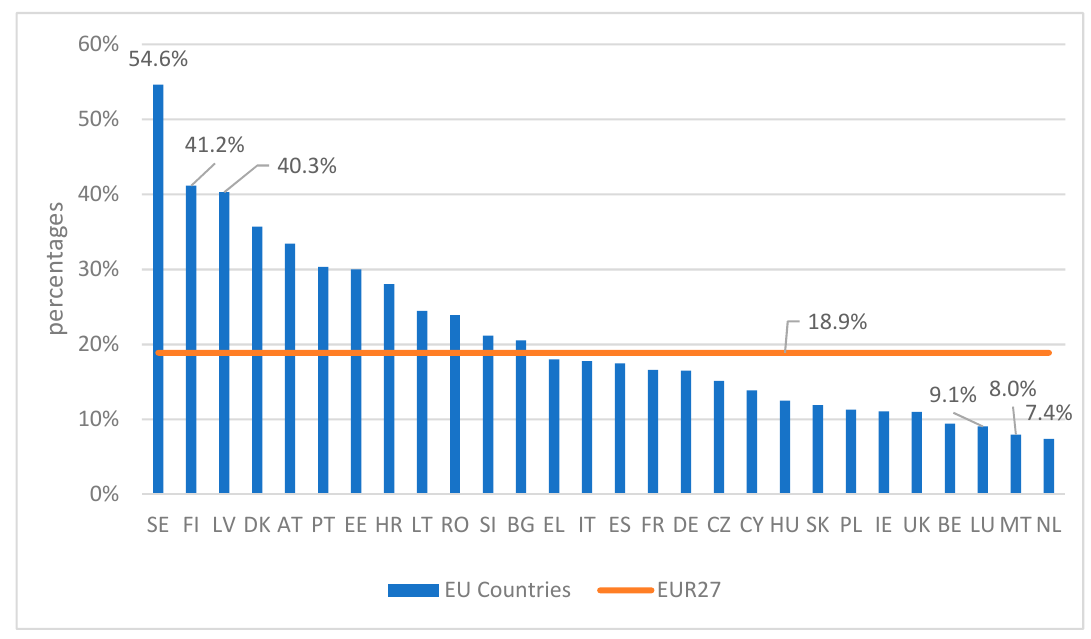
Figure 2. The shares of renewable energy sources (RES) in total energy consumption in EU member states, in 2019. Source: authors’ own computations on the data collected from Eurostat [9].